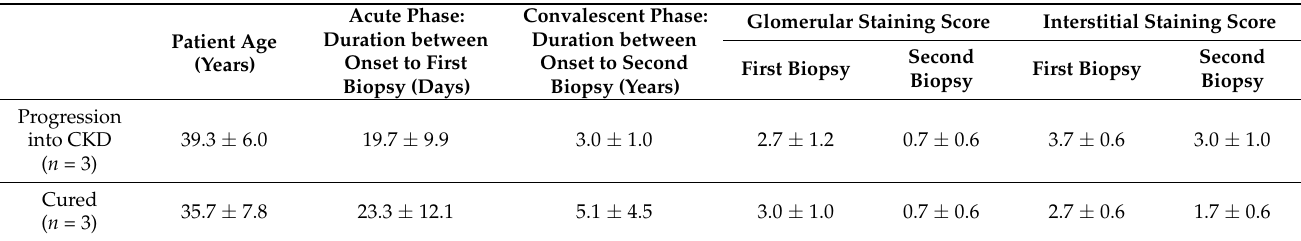
Table 2. Alpha-smooth muscle actin staining scores of renal biopsy tissues sampled repeatedly from 6 PSAGN patients and their characteristics.